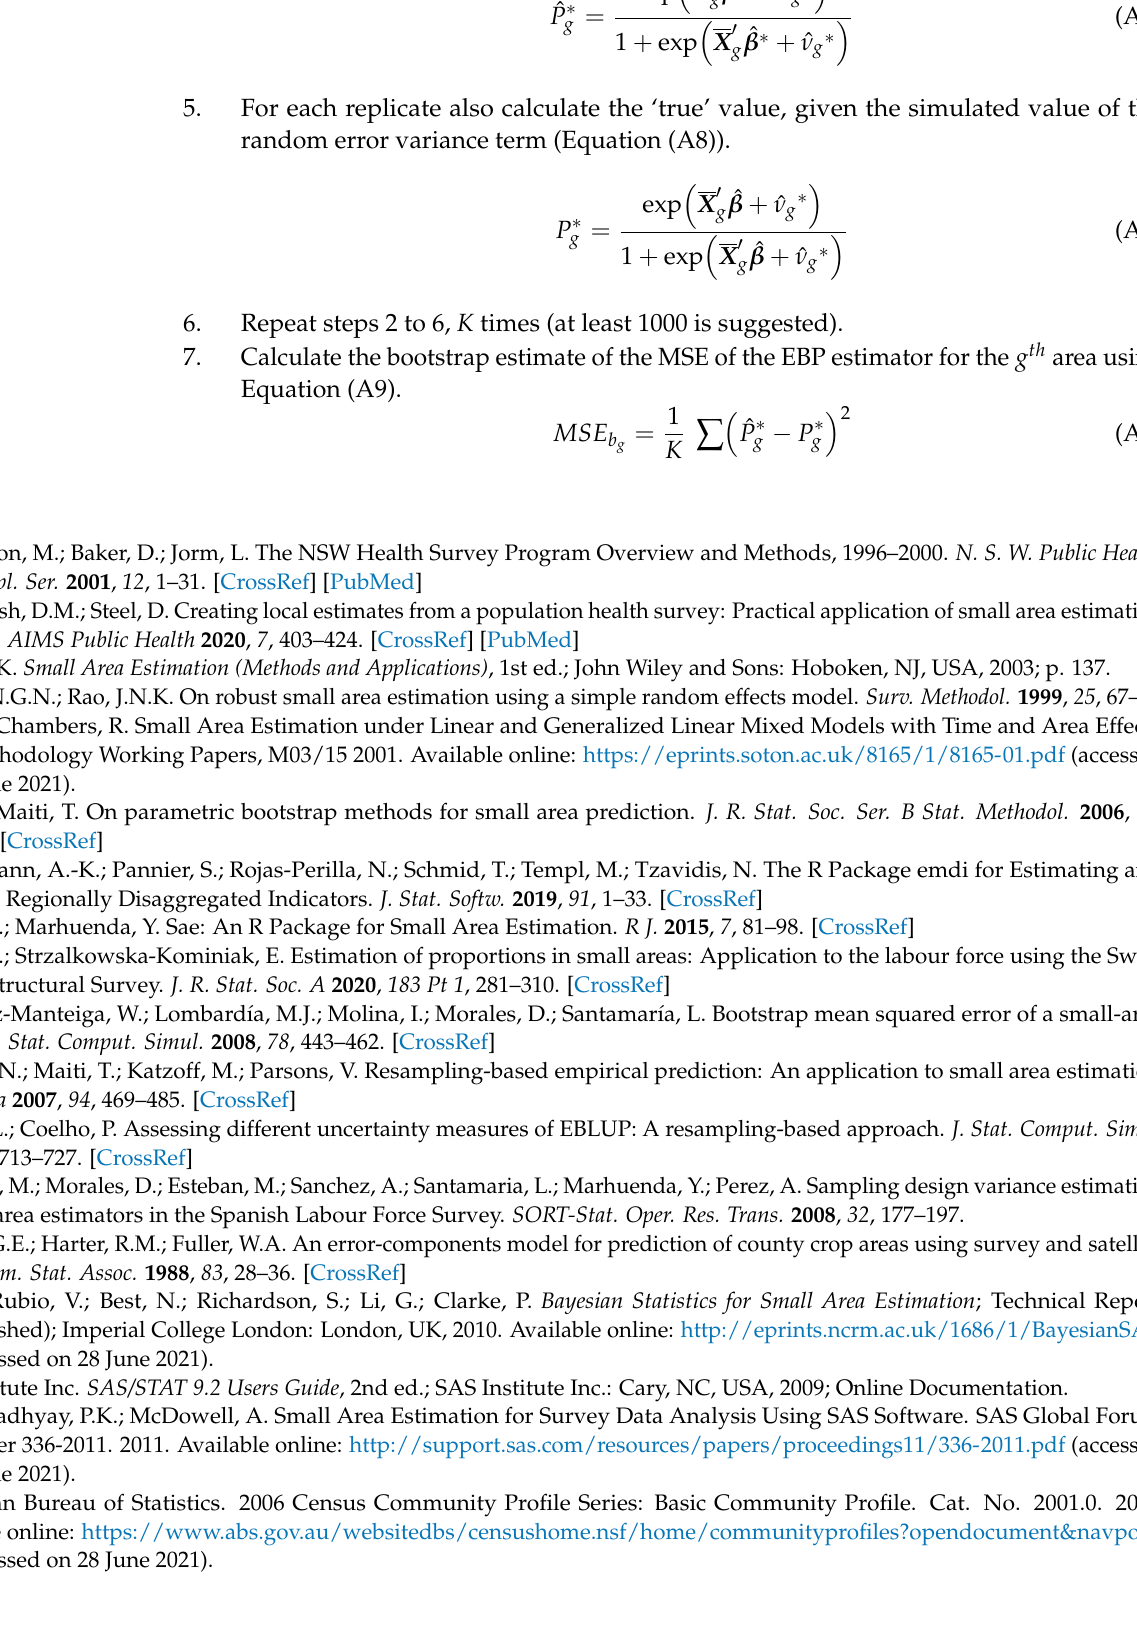
For each replicate also calculate the ‘true’ value, given the simulated value of the random error variance term (Equation (A8)).